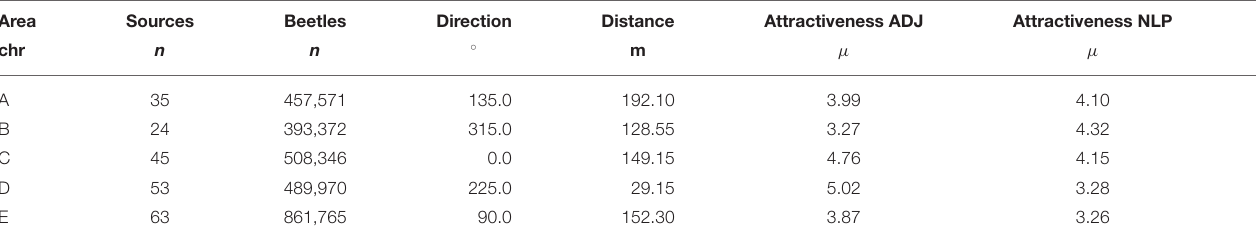
TABLE 5 | Properties of the five research sites investigated during the test of sanitation felling effectiveness on the spread of Ips typographus from the national park (NLP) to the adjacent forest area (ADJ). Area Sources Beetles Direction Distance Attractiveness ADJ Attractiveness